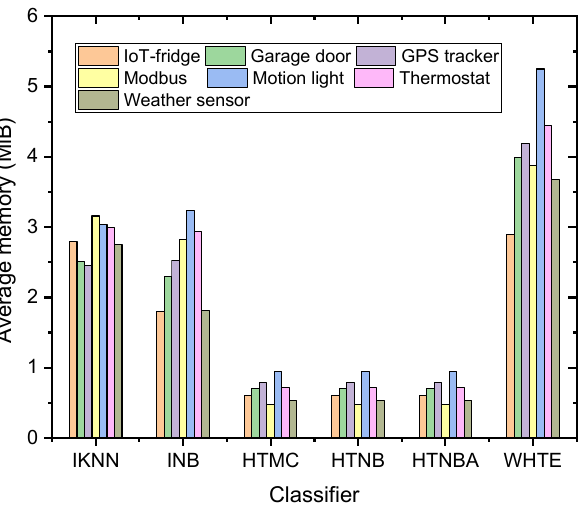
Figure 7. The comparison of the proposed methods in terms of average memory usage among all the datasets.